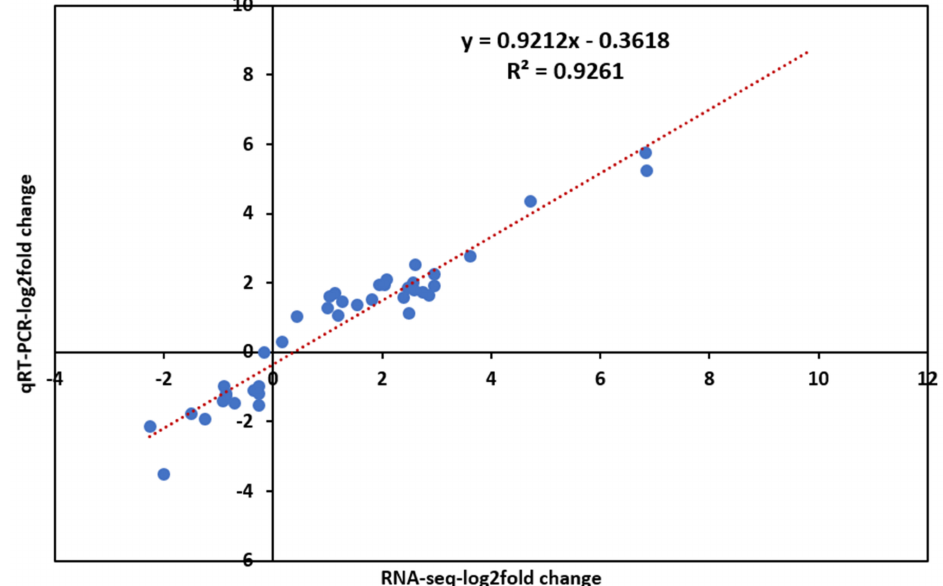
Figure 7. Correlation analysis between RNA-seq and qRT-PCR methods. Log2fold values of RNA-seq data (x-axis) are plotted against log2fold values of qRT-PCR (y-axis)